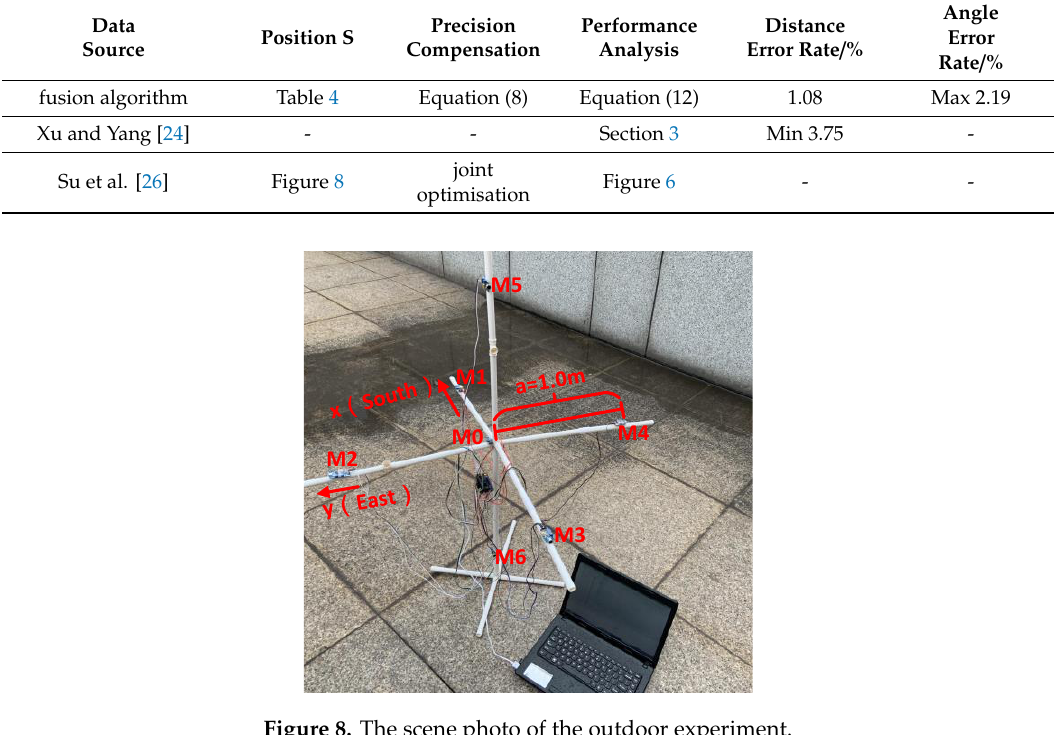
Nanjing 19:42 Figure 9. Radar chart displayed at 19:42.